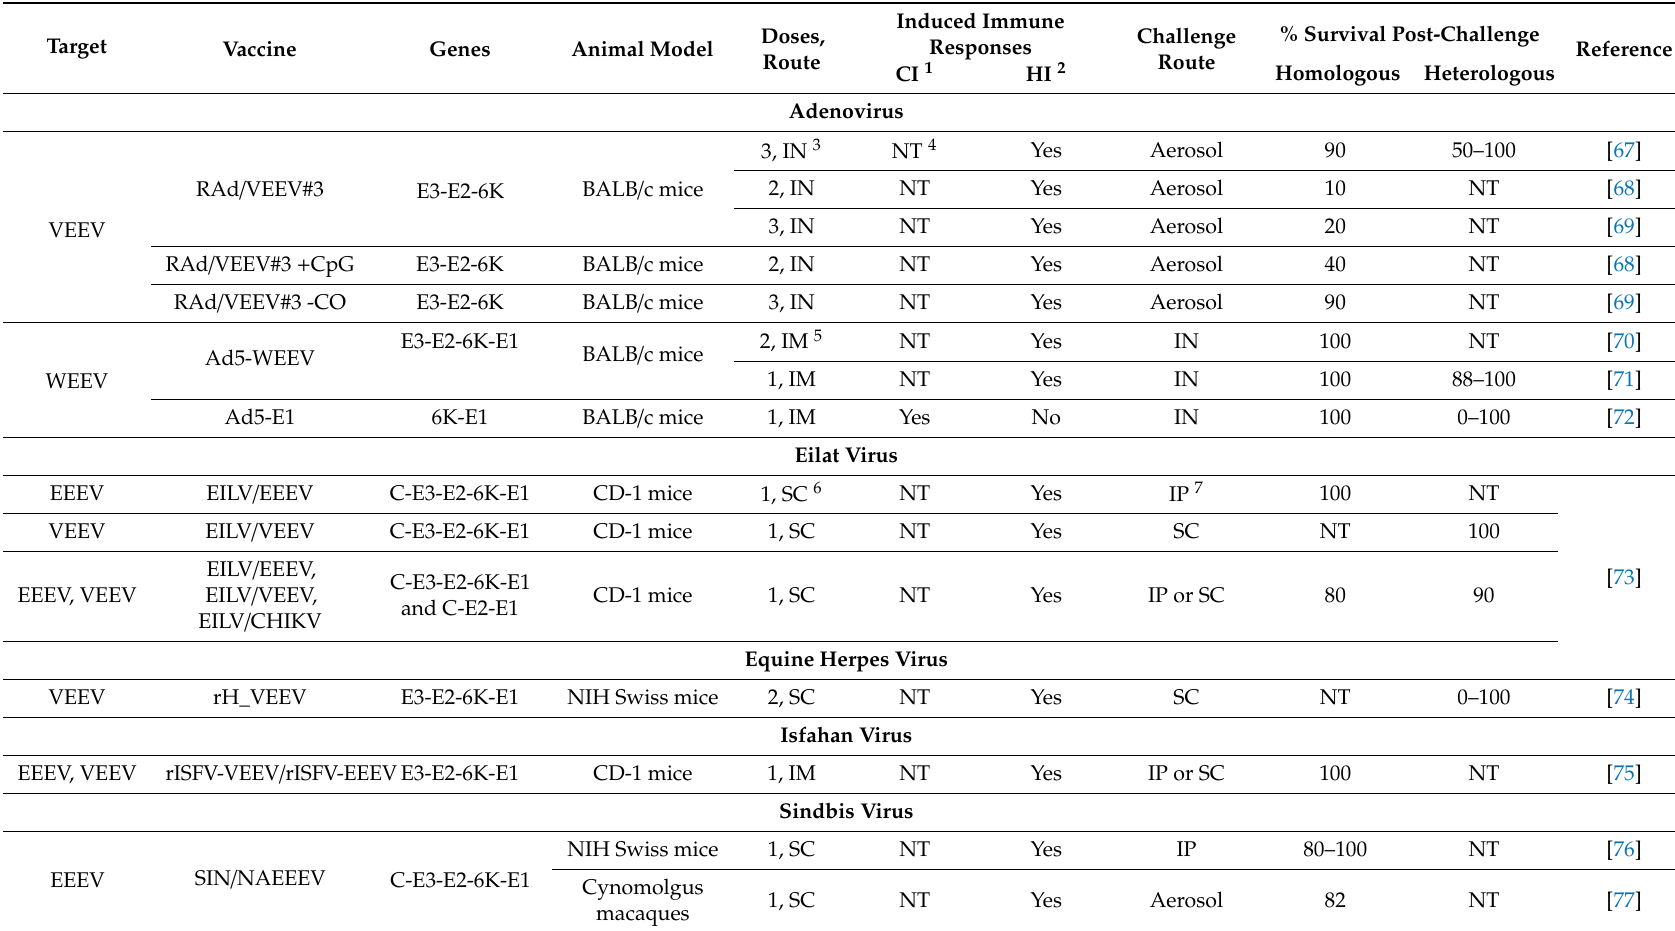
Table 1. Summary of recent recombinant vector vaccine candidates for Eastern, Venezuelan, and Western equine encephalitis